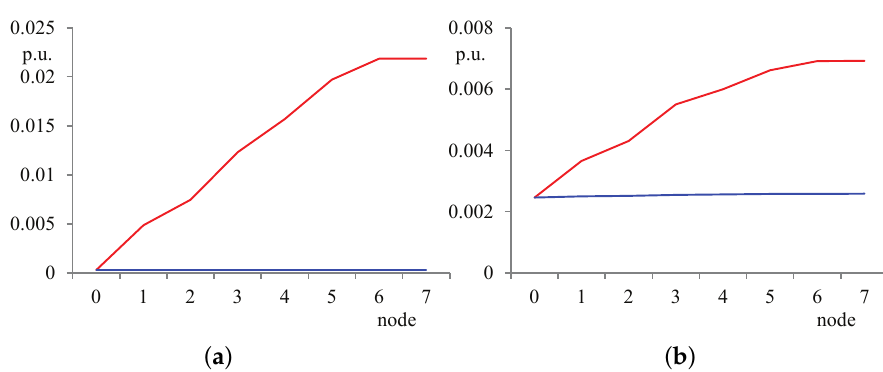
Figure 8. Voltage variations in the case of P DER (red) and feeder 2 (blue).